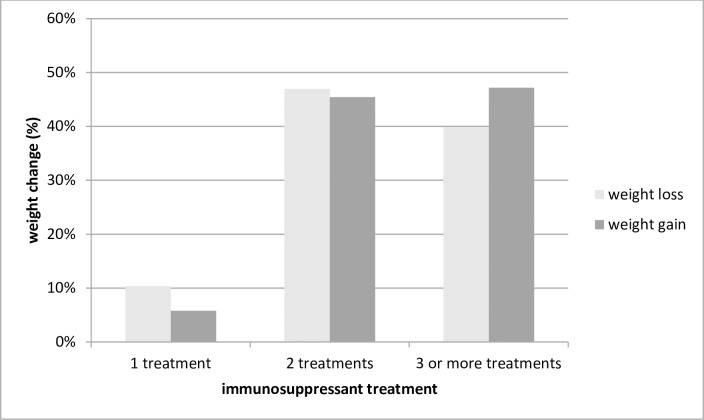
Percentage of weight gain in Sample A at one year after transplantation by number of immunosuppressant treatments (cyclosporine, tacrolimus, glucocorticoids, azatioprine and/or mycophenolate).